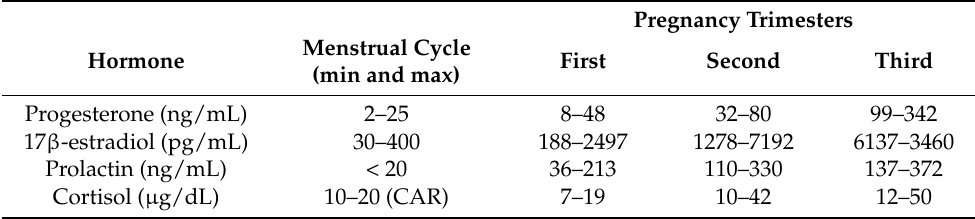
Table 1. Hormonal reference ranges during menstrual cycle and